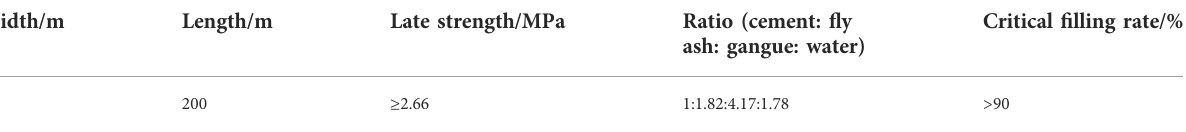
Siltstones Sandy mudstone Siltstone